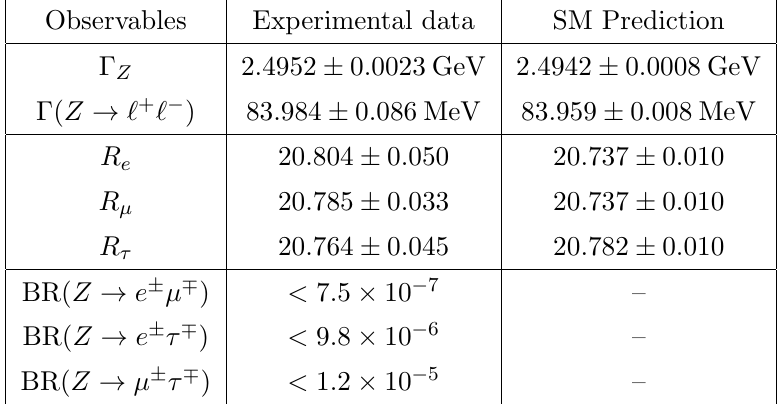
Table 2 . Subset of EWP observables a(cid:11)ected by the modi(cid:12)ed Z couplings, with the cor- responding experimental measurements and SM predictions [1]. The ratios R ‘ are de(cid:12)ned as R ‘ = (cid:0) had = (cid:0)( Z ! ‘ + ‘ (cid:0) ), and (cid:0)( Z ! ‘ + ‘ (cid:0) ) denotes an average over ‘ = e; (cid:22); (cid:28) .